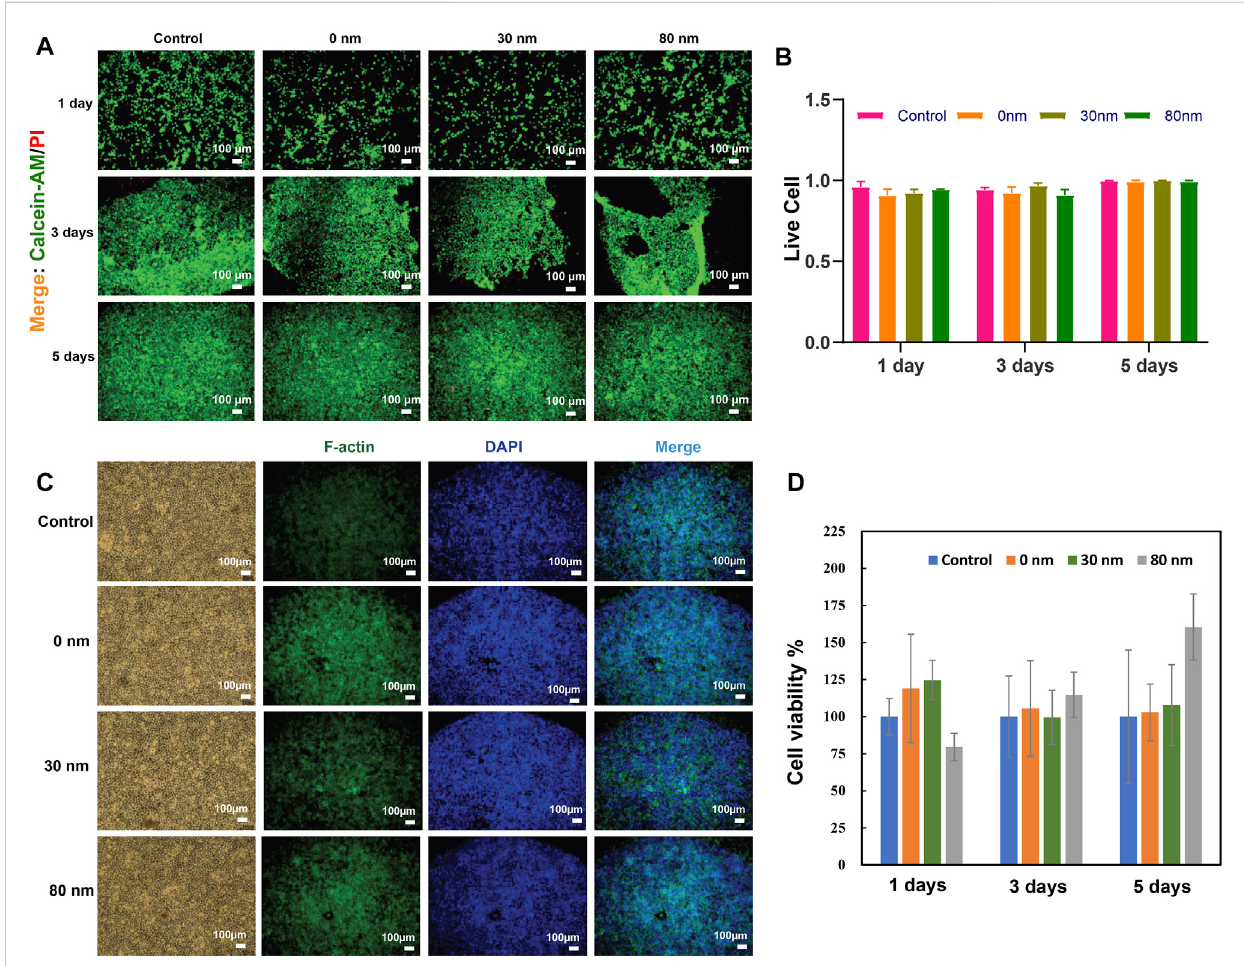
In vitro biological validation with L929 cells. Imaging (A) and counting (B) of live/dead cell assay using the Calcein-AM/PI double staining kit. CytoskeletonassaywithFITC-Phalloidinatday5 (C) .Cellviability/toxicityassaywiththeCCK8kit (D) .Differentmeshsamples(0,30,and80 nm)wereco- cultured with L929cells fordifferentperiods oftime (1,3, and5 days), respectively. Each barrepresents themean ±standarddeviation ofthreebiological replicates. There is no signi fi cant differences between the groups according to the t